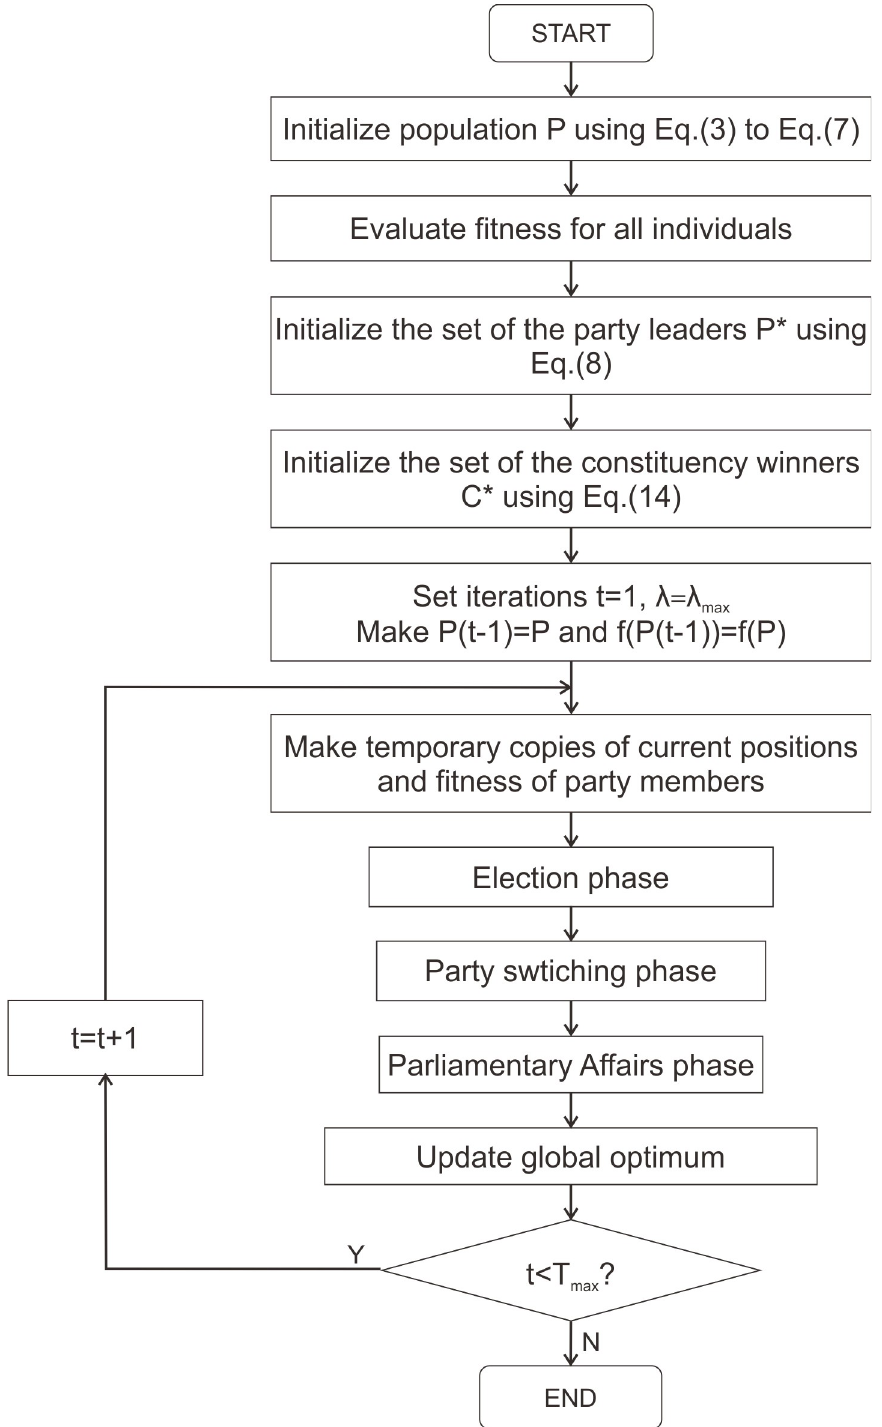
Fig 1. Main step of original